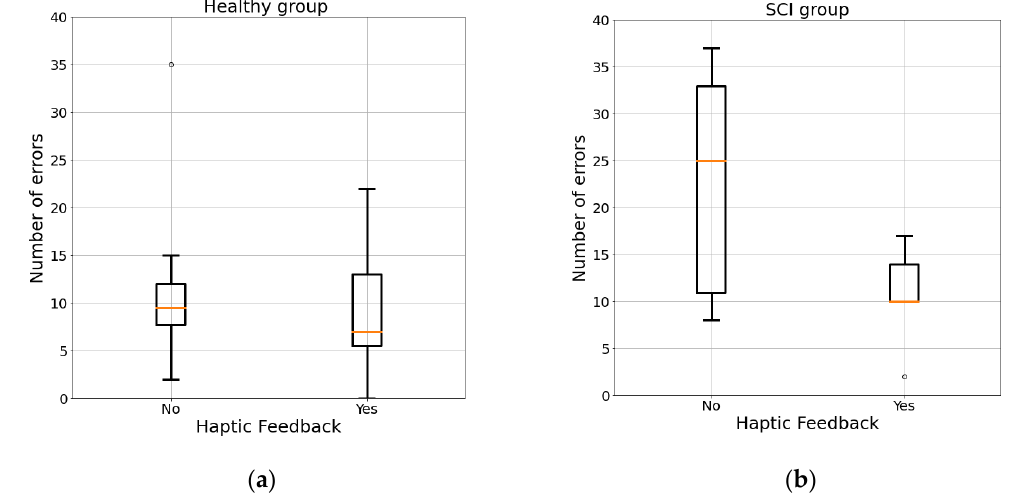
Figure 7. Boxplot of the number of errors for the Maze game comparison with and without haptic feedback for ( a ) healthy subjects and ( b ) SCI patients. Each box comprises observations ranging from the first to the third quartile. The median is indicated by a horizontal bar, dividing the box into the upper and lower part. The whiskers extend to the farthest data points that are within 1.5 times the interquartile range. Outliers are shown as circles. Table 3. Average and standard deviation results for the three games with healthy and SCI groups.